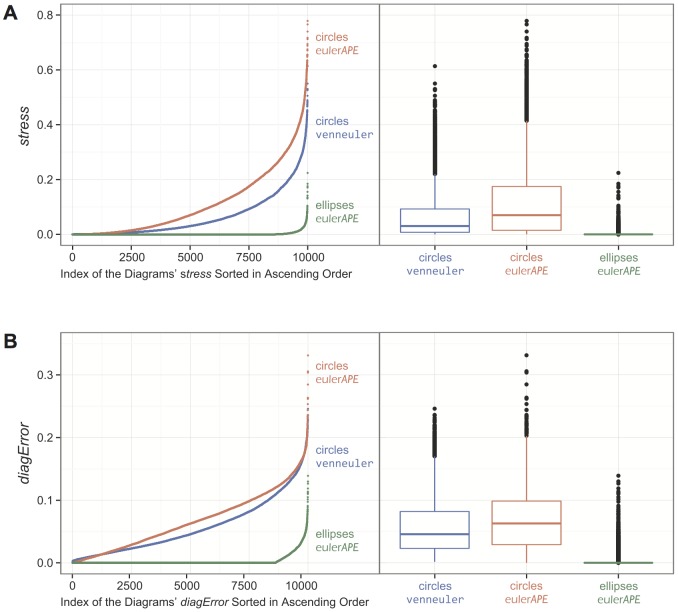

Stress and diagError of all the diagrams generated by venneuler and eulerAPE (circles and ellipses).The (A) stress and (B) diagError of all the diagrams generated with circles by venneuler, with circles by eulerAPE and with ellipses by eulerAPE for the 10,000 3-set data in L2. The 10,000 diagrams generated with circles by venneuler had stress in [3.77×10−5, 6.14×10−1] with median 3.04×10−2 and mean 6.41×10−2, and diagError in [1.56×10−3, 2.46×10−1] with median 4.56×10−2 and mean 5.73×10−2. The 10,000 diagrams generated with circles by eulerAPE had stress in [1.91×10−10, 7.79×10−1] with median 7.00×10−2 and mean 1.13×10−1, and diagError in [3.30×10−6, 3.31×10−1] with median 6.28×10−2 and mean 6.73×10−2. The 10,000 diagrams generated with ellipses by eulerAPE had stress in [3.98×10−14, 2.24×10−1] with median 7.59×10−12 and mean 1.17×10−10, and diagError in [6.00×10−8, 1.39×10−1] with median 8.00×10−7 and mean 2.94×10−3.